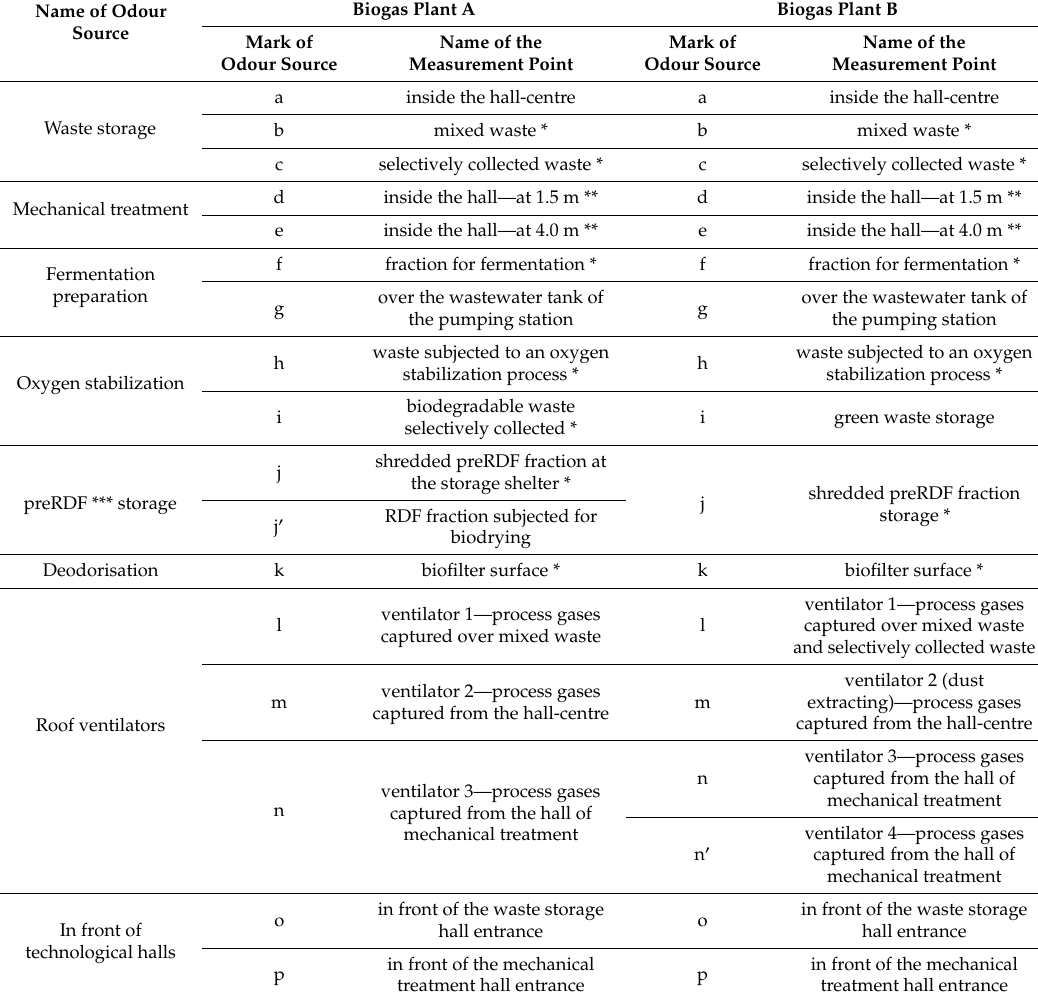
Table 1. Measurement points at the examined biogas plants.